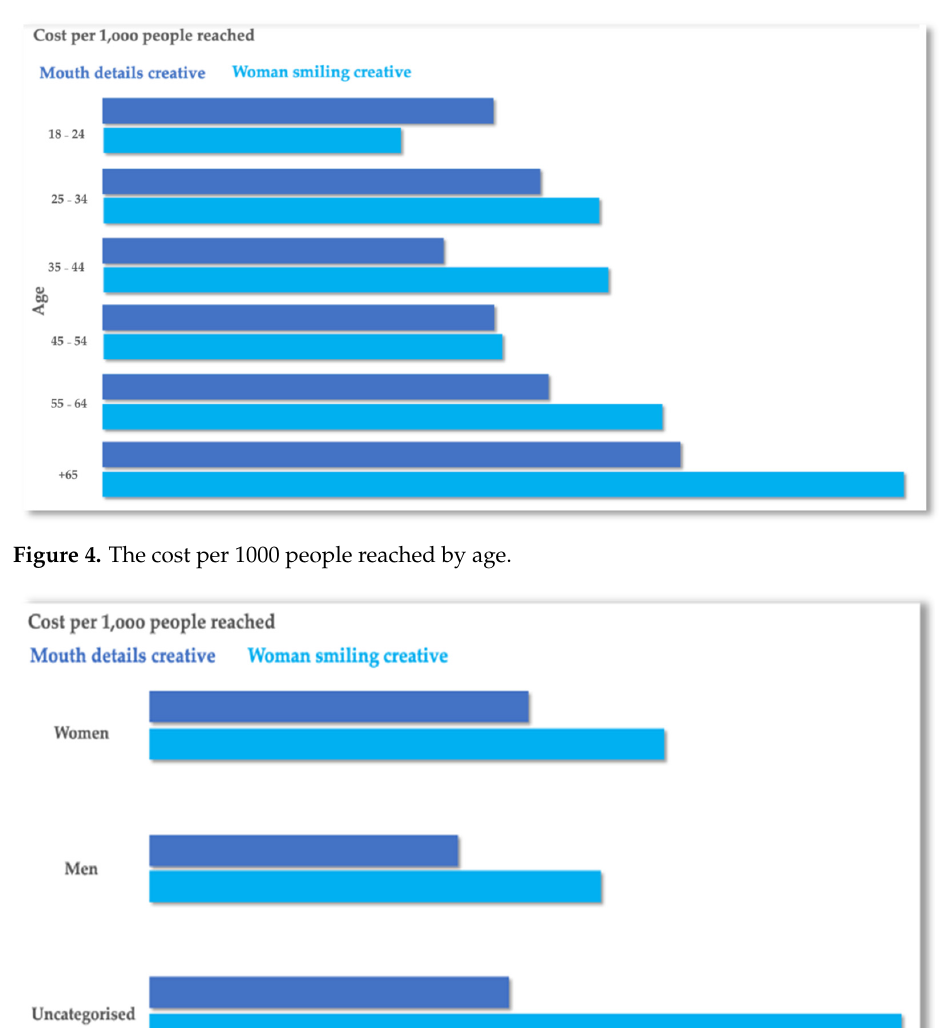
Figure 5. The cost per 1000 people reached by gender.